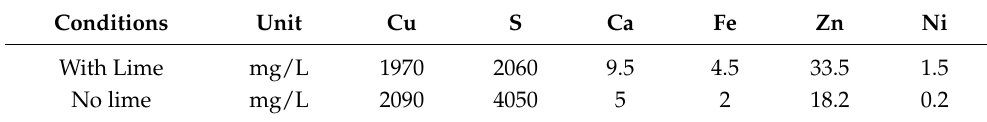
Table 7. Elemental assay of final